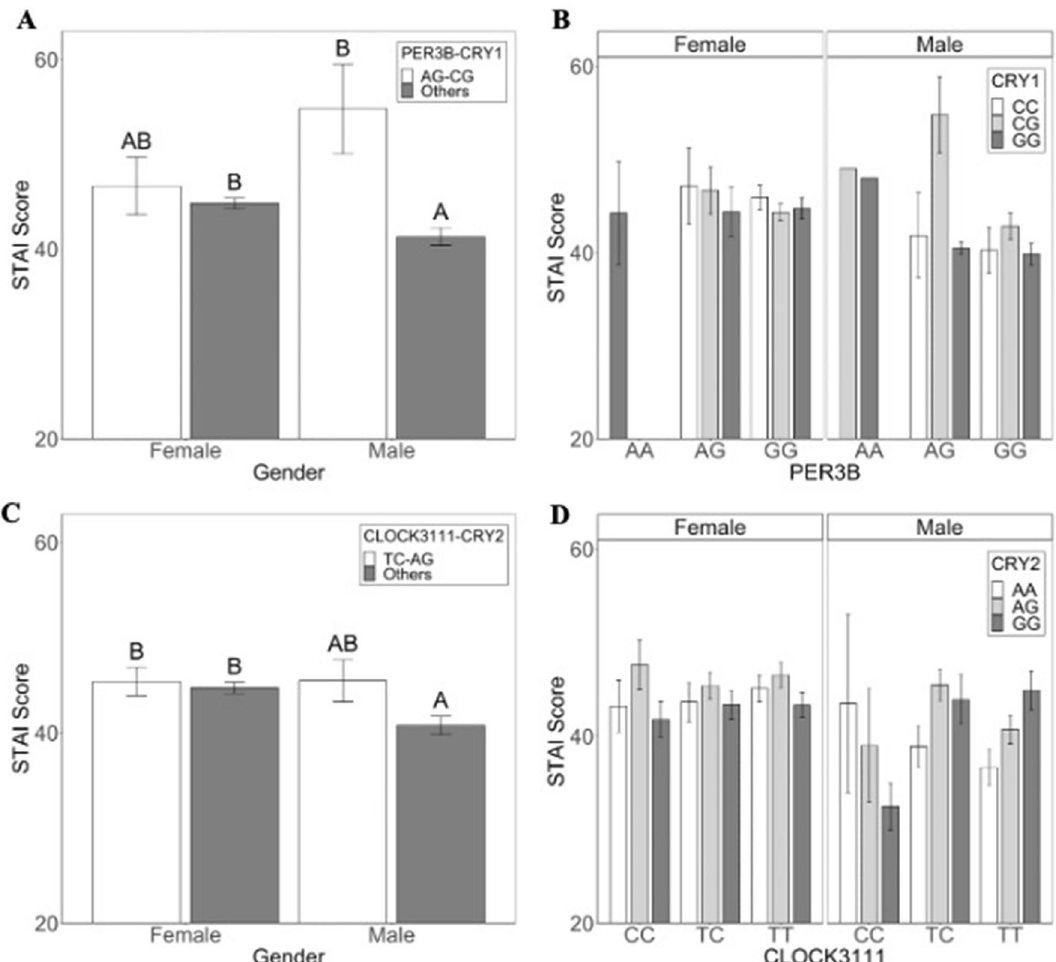
Figure 2. Genotype combinations predictive of anxiety symptoms in males. ( A,B ) Average anxiety scores for males with a combination of PER3B -AG and CRY1 -CG are higher than average anxiety scores of individuals with other genotype combinations (Gender: F 1, 479 = 0.661, p = 0.417, Genotype: F 1, 479 = 7.174, p = 0.008; Gender x Genotype: F 1, 479 = 4.141, p = 0.042). Anxiety scores are measured using the self-reported State-Trait Anxiety Index (± 1 SE). Tukey’s posthoc tests showed that males with AC-CG combination were significantly different from males with other genotypes and from females. ( C,D ) Average anxiety scores of males with a combination of CLOCK 3111-TC and CRY2 -AG also tend to be higher than average anxiety scores of individuals with other genotype combinations, but this is not significant at p < 0.05. (Gender: F 1, 517 = 1.773; p = 0.184 , Genotype:F 1, 517 = 3.417; p = 0.065; Gender x Genotype: F 1, 517 = 1.912, p =